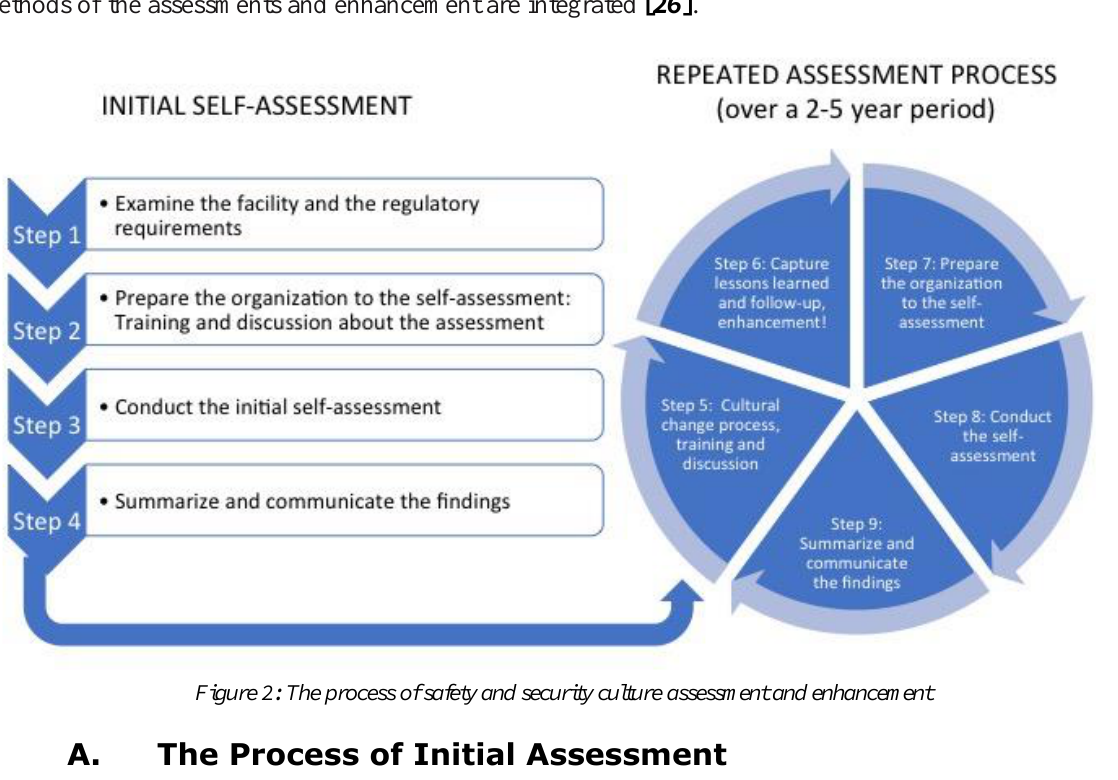
Figure 2: The process of safety and security culture assessment and